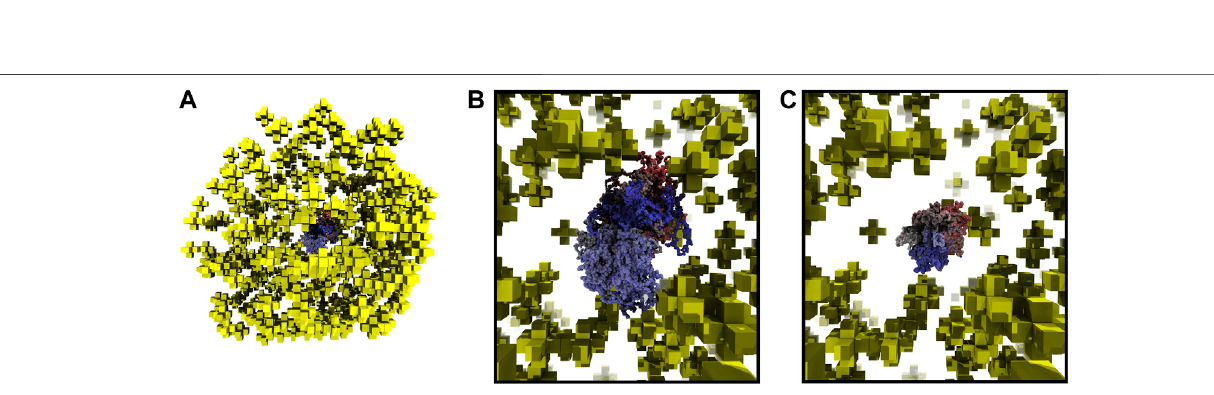
FIGURE 6 | (A) — Centroid of 30 chromosome con fi gurations is shown within the ribosome distribution. The same color scheme for centroid is used as for the chromosome in Figure 5 . (B) — Magni fi ed view of centroid in 6A calculated from 30 con fi gurations, radius of gyration is 24.93 nm. (C) — Magni fi ed view of centroid calculated from 90 con fi gurations, radius of gyration is 11.99